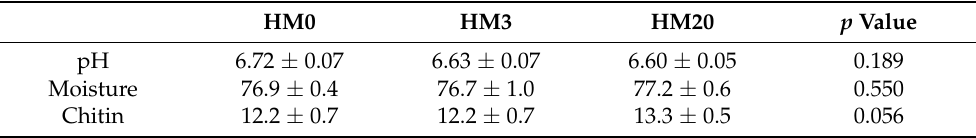
Table 6. pH and moisture (g/100g of muscle) measured in the muscle and chitin content (g/100g of freeze-dried exoskeleton) measured in the exoskeleton from giant freshwater prawns fed the experimental diets over the 60-day